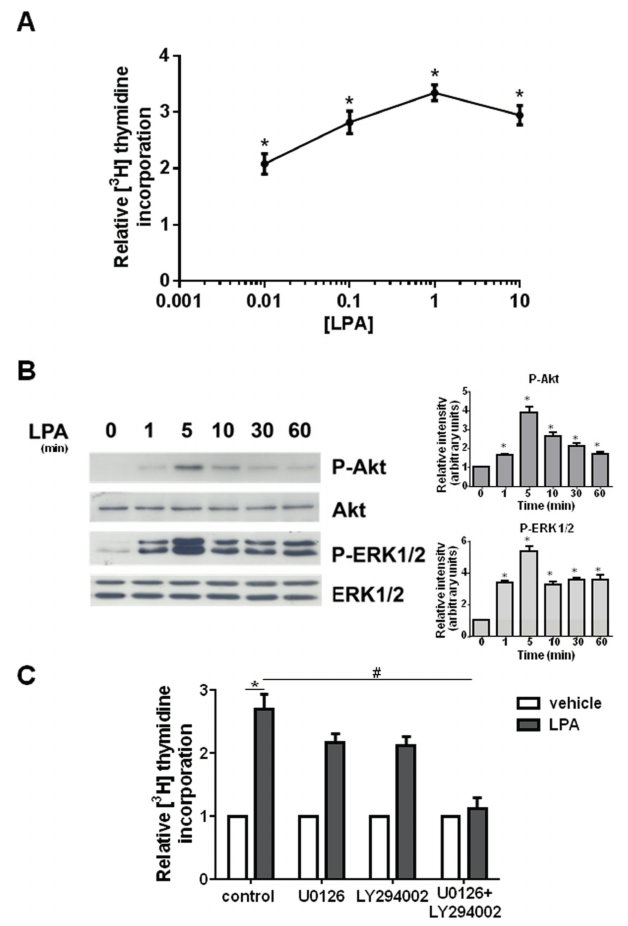
Figure 5. LPA induces cell proliferation via ERK1/2 and Akt in myoblasts. ( A ) Serum-starved C2C12 myoblasts were treated with LPA at the indicated concentrations (0.01–10 µ M) for 16 h. [ 3 H]Thymidine (0.5 µ Ci/well) was added during the last hour of incubation. Data are mean ± SEM of at least three independent experiments performed in triplicate. The mitogenic effect of LPA was statistically significant by one-way ANOVA followed by Bonferroni’s post hoc test (* p < 0.05). ( B ) Western blot analysis was performed using specific anti-phospho-ERK1/2 and anti-phospho-Akt antibodies in cell lysates prepared from serum-starved myoblasts treated with 100 nM LPA for the indicated time intervals. A blot representative of at least three independent experiments with analogous results is shown. Right panels: Band intensity was quantified by densitometric analysis and normalized to the expression of total ERK1/2 and total Akt, respectively. LPA activates ERK1/2 and Akt in a statistically significant manner by one-way ANOVA followed by Bonferroni’s post hoc test (* p < 0.05). ( C ) Serum-starved C2C12 myoblasts were pre-incubated for 30 min in the presence or absence of 5 µ M U0126, 5 µ M LY294002 or 5 µ M U0126 together with 5 µ M LY294002 before being stimulated with 100 nM LPA for 16 h. [ 3 H]Thymidine (0.5 µ Ci/well) was added during the last hour of incubation. Data are mean ± SEM of at least three independent experiments performed in triplicate. [ 3 H]Thymidine incorporation in untreated control cells was 21,181.25 ± 417.19 dpm, in U0126 treated cells was 6252.67 ± 319.27 dpm, in LY294002 treated cells was 2438.66 ± 221.66 dpm in U0126 and LY294002 treated cells was1594.33 ± 91,30 dpm. The mitogenic effect of LPA was statistically significant by Student’s t test (* p < 0.05). The effect of both ERK1/2 and Akt inhibition was statistically significant by two-way ANOVA followed by Bonferroni’s post hoc test ( # p < 0.05). To elucidate the molecular mechanism by which exogenously added LPA exerts its mitogenic action, we analyzed whether the activation of ERK1/2 and Akt relies on LPA 1 and LPA 3 engagement. As